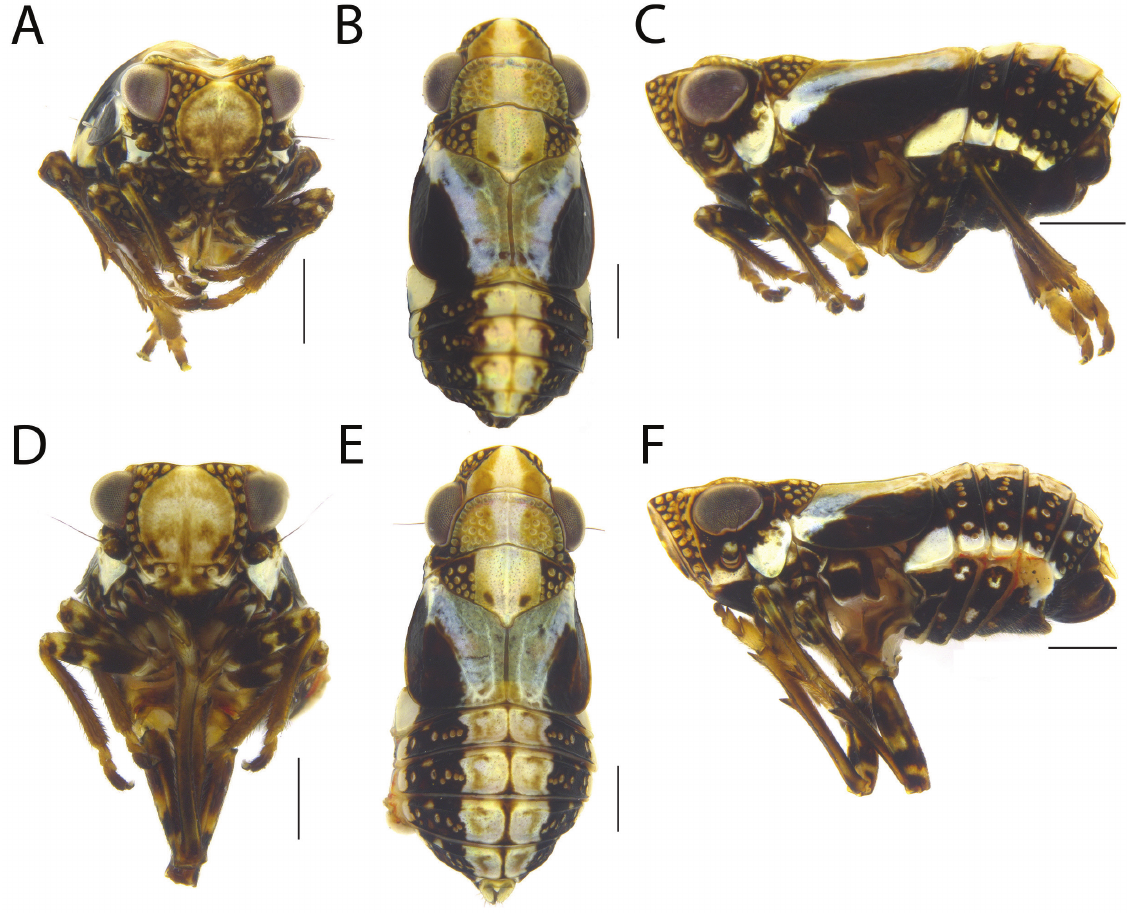
Fig. 21. Habitus of Protrocha nigrilutea sp. nov. A–C . Holotype, ♂ (INHS). A . Frontal view. B . Dorsal view. C . Lateral view. D–F . Paratype, ♀ (INHS). D . Frontal view. E . Dorsal view. F . Lateral view. Scale bars = 0.5